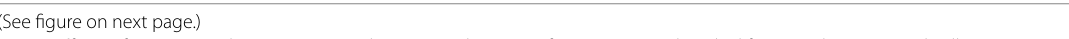
sicirc, LPS sicirc I groups were detected by ELISA and qRT-PCR. N 3 for each column; + + + = siCirc; One-way ANOVA + 3 for each column; = siCirc; One-way ANOVA +